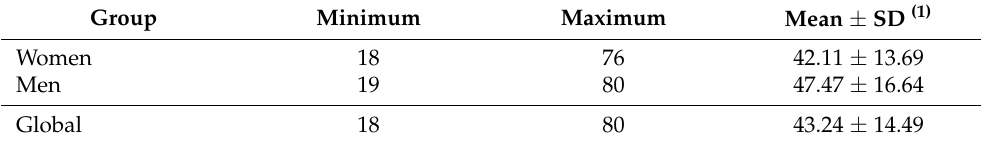
Table 1. Age of the participants.